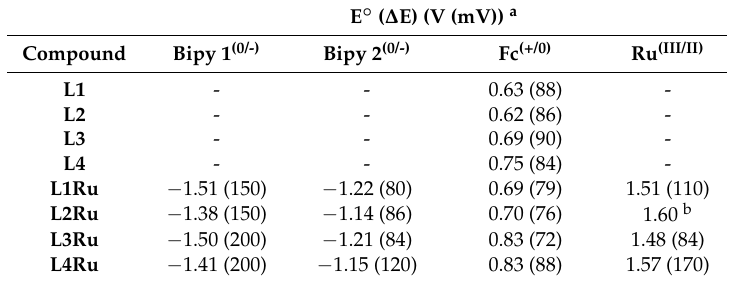
Table 1. Formal electrode potentials (E ◦ ) exhibited by L1 – L4 and L1Ru – L4Ru in dichloromethane (DCM)